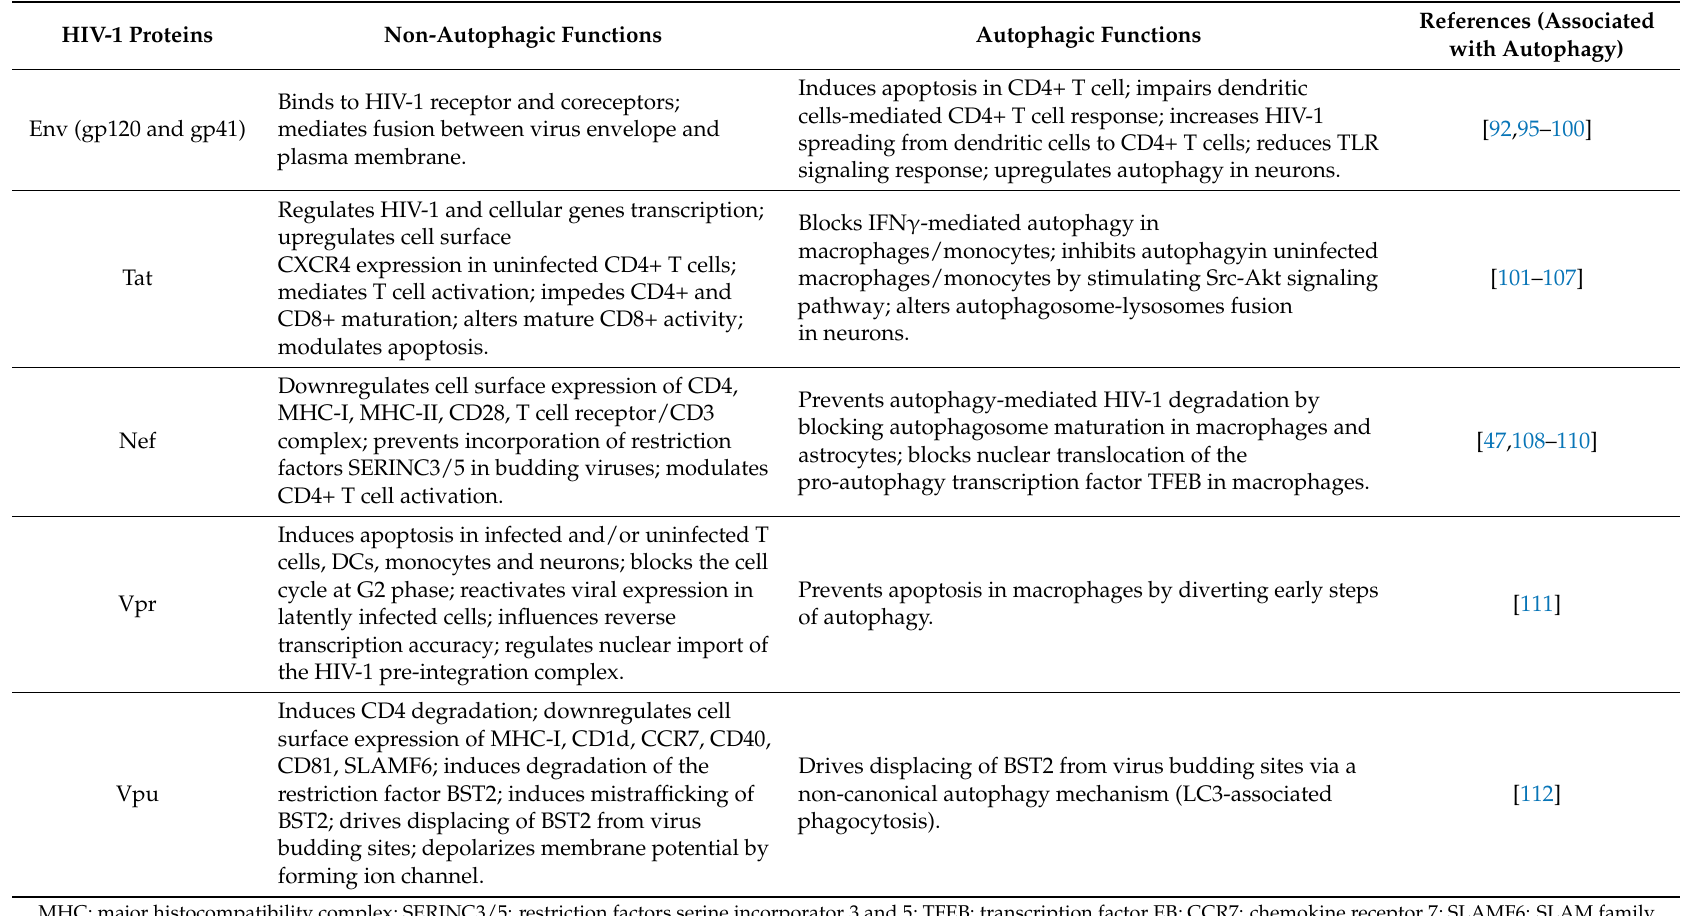
Table 1. Non–autophagic and autophagic functions of HIV-1 Env, Tat, Nef and Vpu